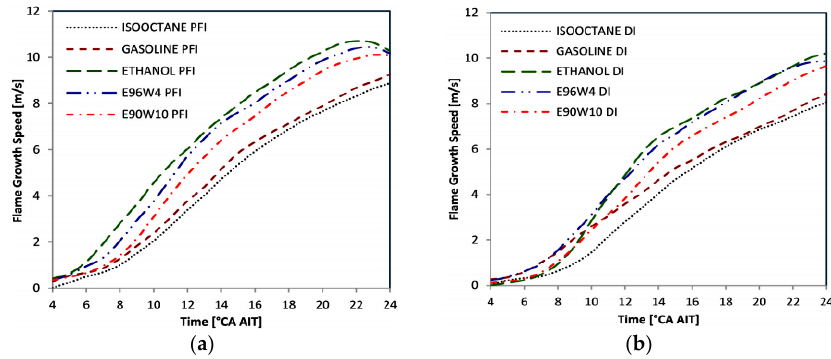
Figure 4. Flame growth speed for ( a ) PFI and ( b ) DI operation, for the first 24° CA of combustion at a fixed engine speed of 1000 rpm and an equivalence ratio 1. Reprinted with permission from Ref. [68]. Copyright (2014) SAE International.